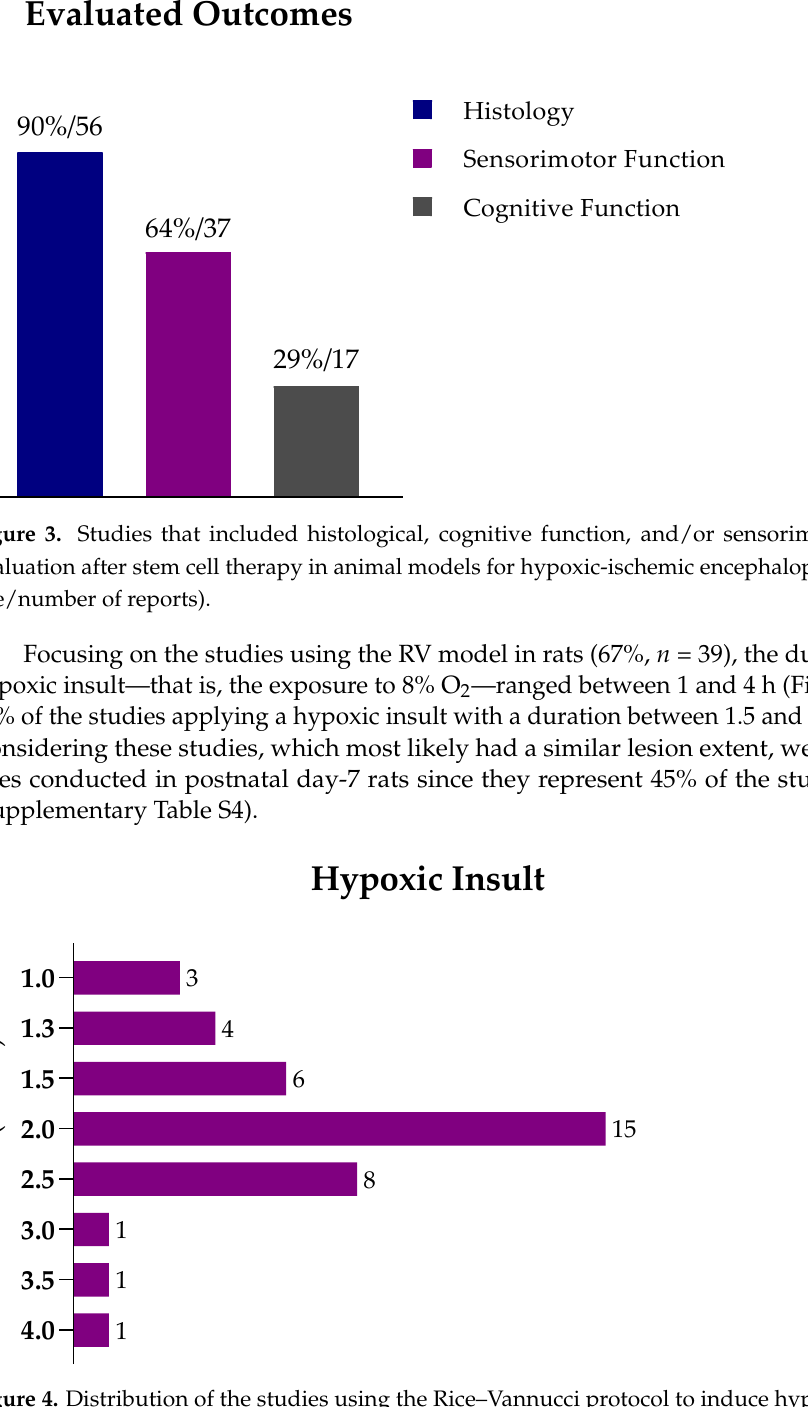
Figure 4. Distribution of the studies using the Rice–Vannucci protocol to induce hypoxic-ischemic brain lesion in neonatal rats regarding the hypoxic insult’s duration in hours.